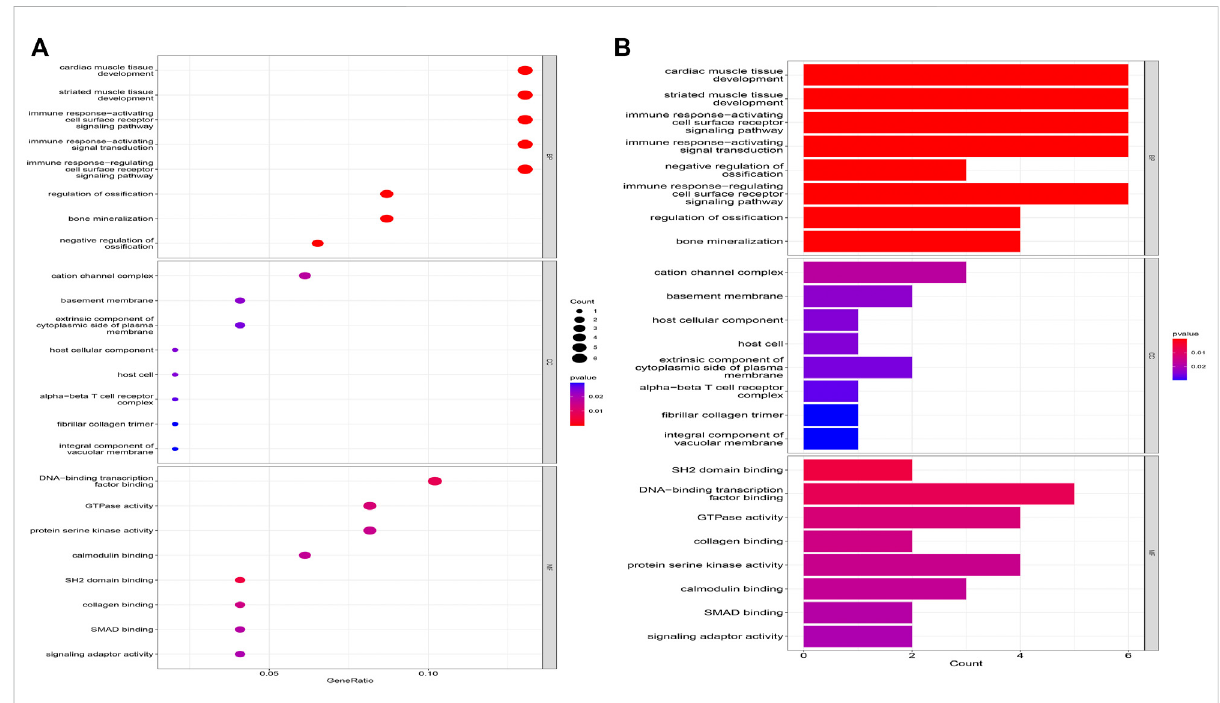
FIGURE 2 Results of GO analysis. (A) Bubble diagram; (B) bar graph.